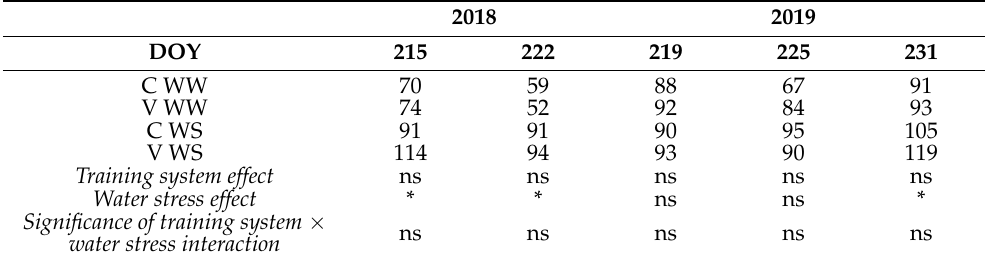
Table 5. WUEi (An/gs) during the 2018 and 2019 seasons. Values represent means of 4 replicates. C WW = well-watered vertical shoot-positioned canopy, V WW = well-watered V-shaped open canopy, C WS = vertical shoot-positioned canopy with water restriction, V WS = V-shaped open canopy with water restriction. Significant differences are indicated: *, p < 0.05; ns, not significant. Mean values were separated within each column with different letters using the Tukey